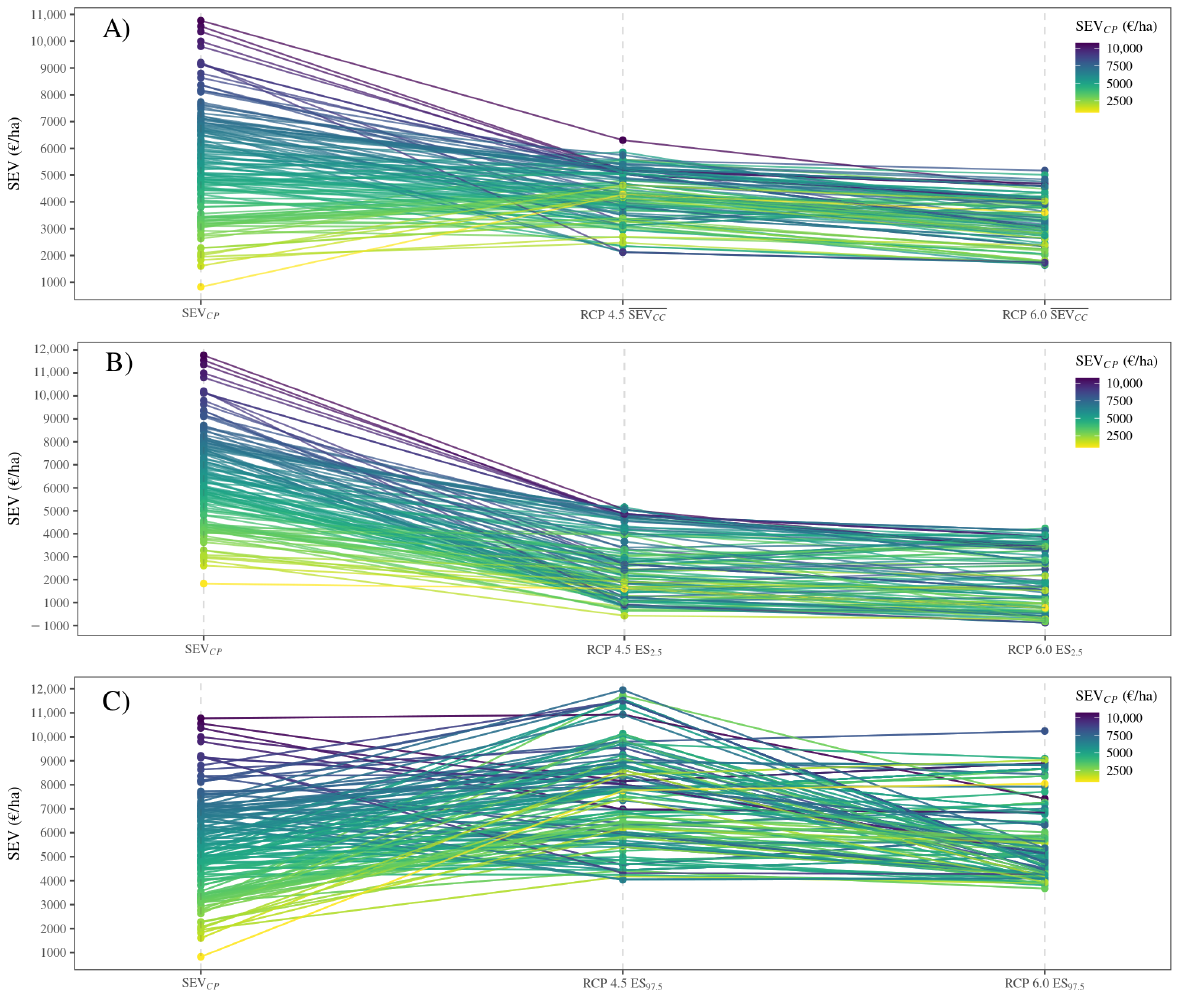
Figure 3. Parallel coordinates plots representing the change from SEV under current productivity (SEV CP ) to ( A ) mean SEV under climate change (SEV CC ), ( B ) future ES 2.5 and ( C ) future ES 97.5 for an interest rate =